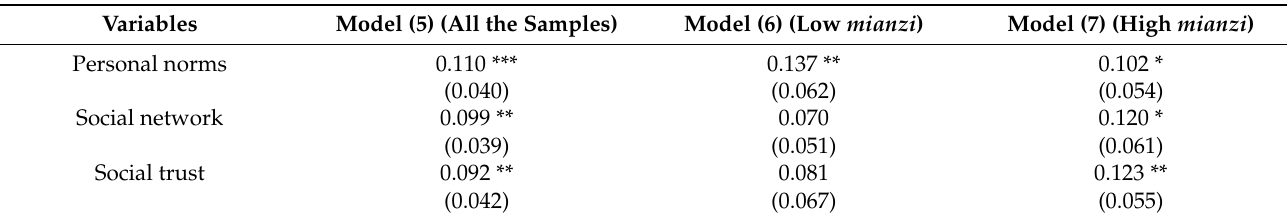
Table 5. Results of the moderating effect of mianzi